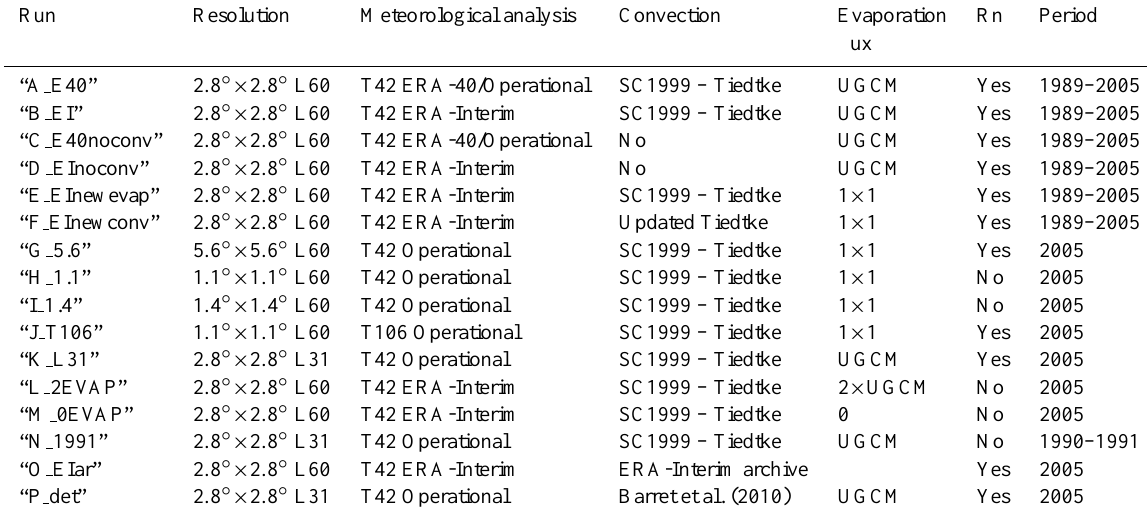
Table 1. TOMCAT model